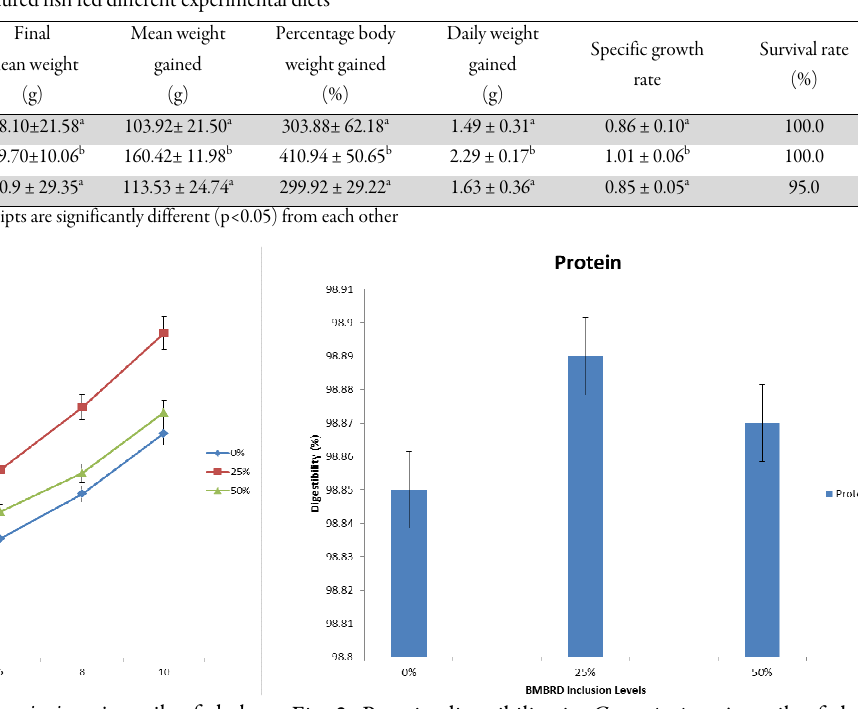
Fig. 2. Protein digestibility in C. gariepinus juveniles fed the experimental diets